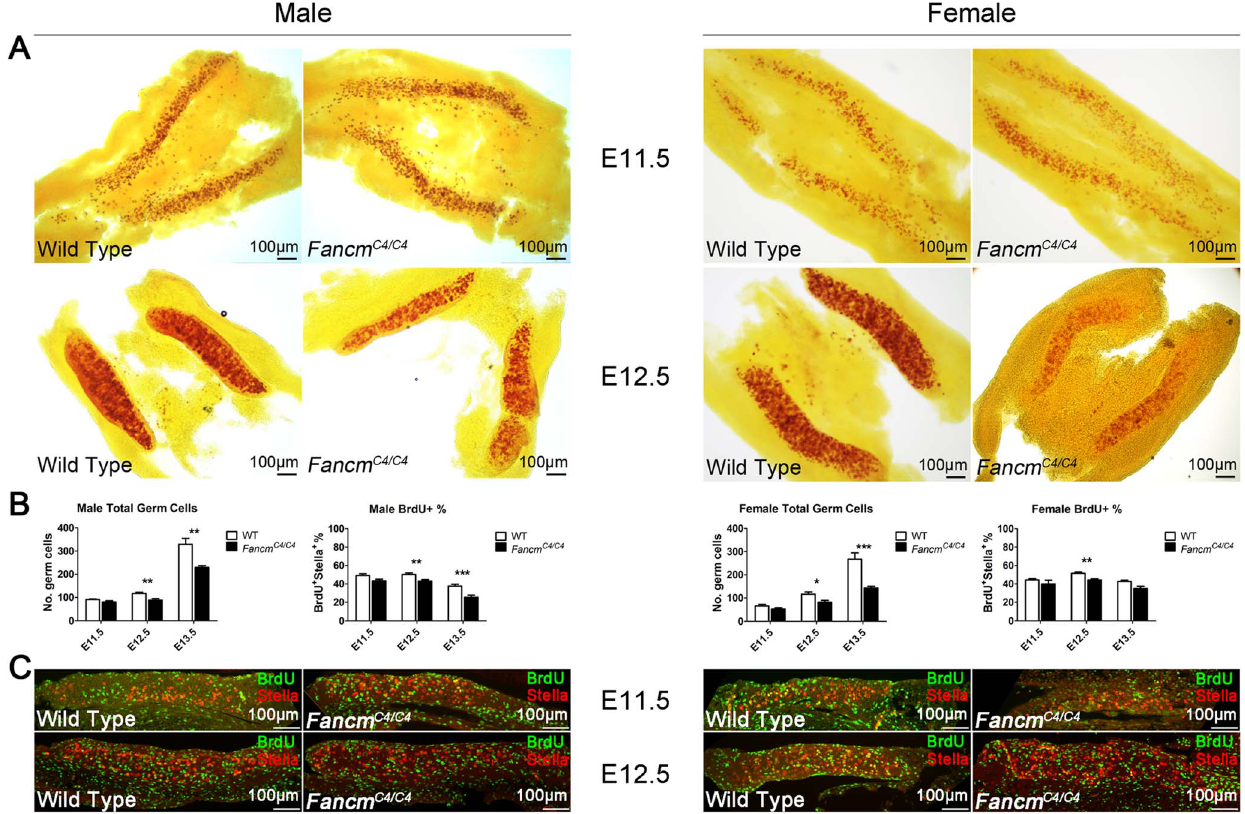
Figure 6. PGC depletion in Fancm C4/C4 mice is associated with reduced proliferation, not apoptosis. (A) Male and female embryonic gonads from E11.5 and E12.5 stained for alkaline phosphatase activity. A decrease in PGCs is becomes evident only at the latter time point. The graphs of germ cells in (B) represent quantification of germ cells by immunolabelling fetal gonads with either Stella (E11.5 and E12.5) or MVH (E13.5). Representative images for E13.5 gonads are shown in Figure S2. The graphs of BrdU + cells represent data from BrdU incorporation assays shown in (C and Figure S2). BrdU and Stella double-positive cells, which represent PGCs in S phase, were quantified as percentage of total Stella-positive PGCs.